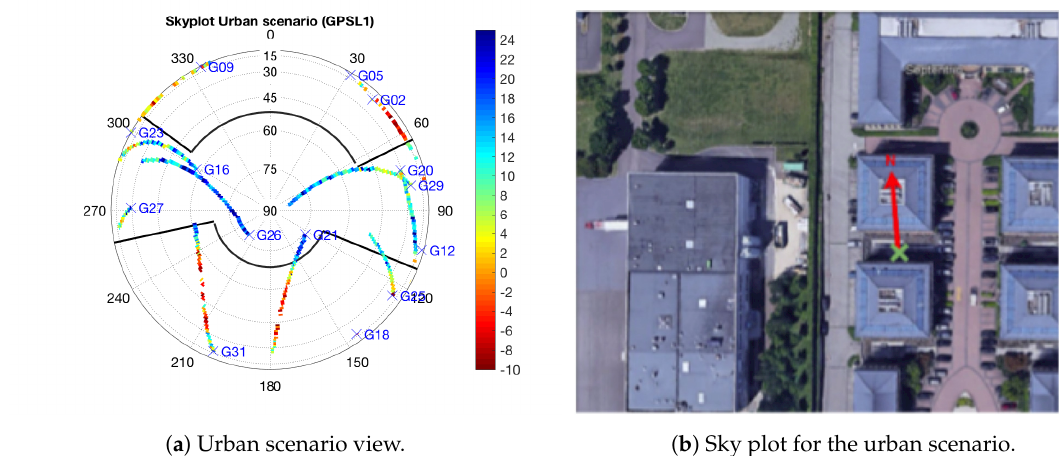
Figure 8. ( a ) RLR in a sky plot for the urban environment. Elevation masks based on the known location of the buildings in the scenario (see ( b